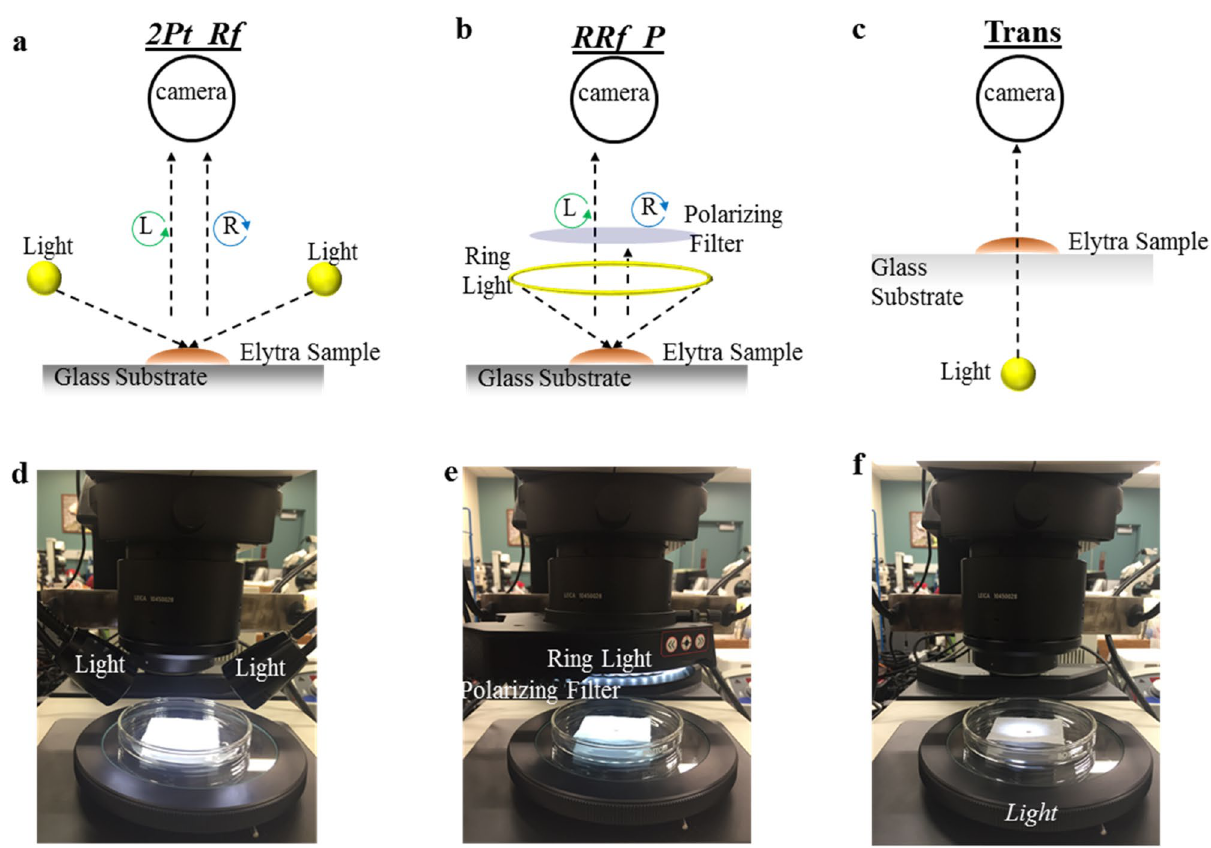
Figure 1. Schematic and experimental setup for three lighting conditions used in this study; (a–c) schematic ray-diagram for the imaging conditions and (d–f) actual laboratory